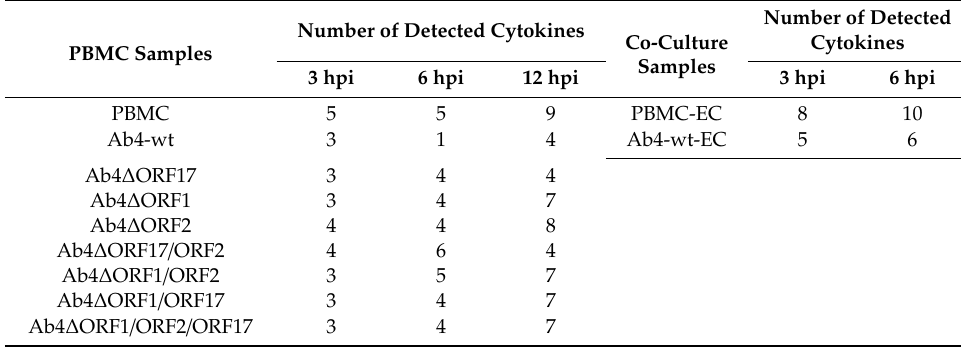
Figure 7. PBMC cytokine and chemokine profile at 3, 6, and 24 hpi. Equine PBMC were infected with either Ab4-wt or mutant viruses at an MOI of 1. ( A ) At 3 hpi, ( B ) 6 hpi, and ( C ) 24 hpi, supernatants were collected, and cytokines and chemokines were quantified using a Milliplex ® MAP equine cytokine / chemokine magnetic bead-based Multiplex kit with Luminex-based detection system. Mean concentrations of cytokines and chemokines are given in picogram (pg) per mL; ( n = 2). hpi—hours post infection. Table 5. Compiled cytokine and chemokines